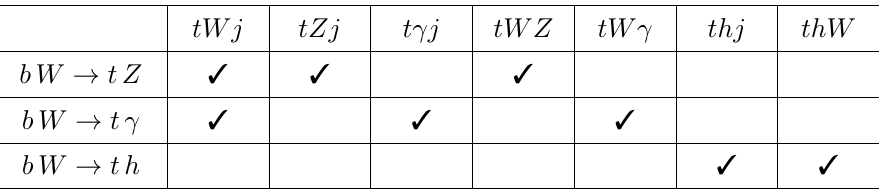
Table 4. The set of single-top 2 2 scattering amplitudes considered in this work mapped to the ! collider processes in which they are embedded.